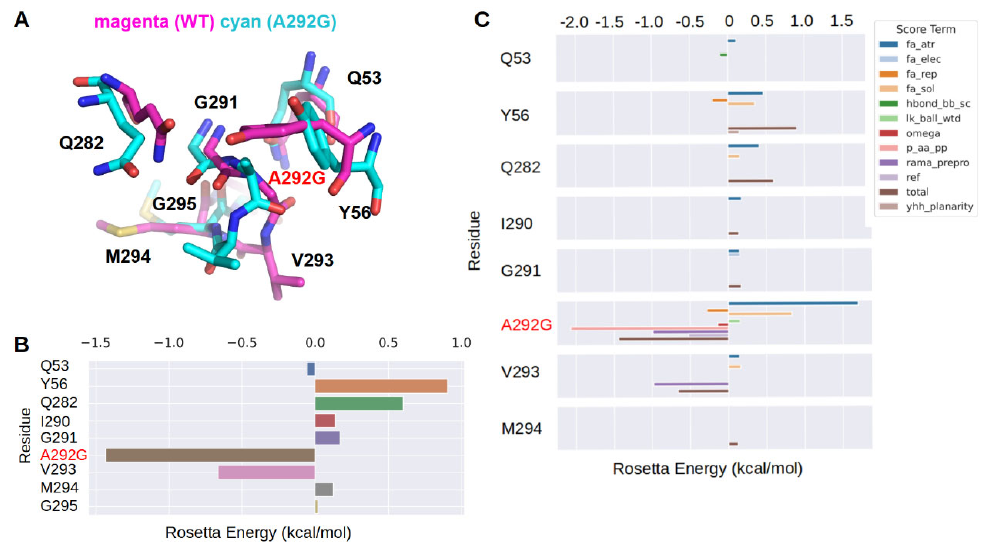
Figure 9. Energy contribution to the favored Rosetta-predicted ∆∆ G for the A292G mutant. ( A ) Structural models of residue 292 and its interacting residues are shown based on representative snapshots at 200 ns in MD simulation trajectories for the WT and A292G. The residues are shown as sticks. Nitrogen, oxygen, and sulfur atoms are colored in blue, red, and yellow, respectively. Carbon atoms are colored in cyan for the WT and magenta for A292G. ( B ) Rosetta ∆∆ G energy (kcal/mol) is shown for A292G and its interacting residues. ( C ) Decomposition of the change in Rosetta energy to individual energy score terms for respective residues. The energy score terms are color ‐ coded and their meanings are described in Figure 7’s description.